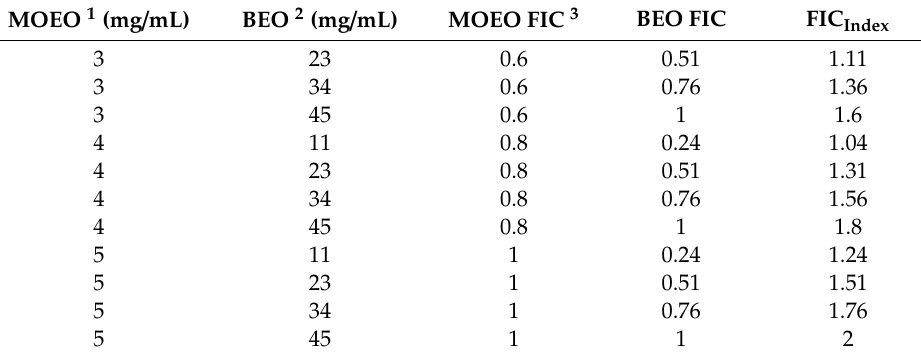
Table 2. Combined e ff ect of essential oils against Escherichia coli O157:H7. MOEO 1 (mg / mL) BEO 2 (mg / mL) MOEO FIC 3 BEO FIC FIC